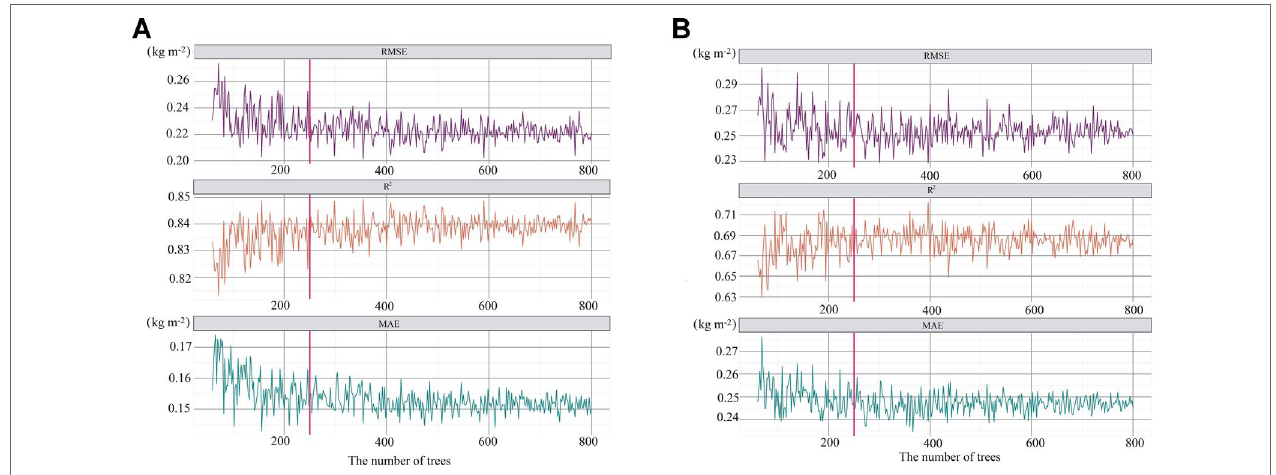
FIGURE 6 | Average accuracy of five-fold cross-validation of RF Model in training samples (A) and testing samples (B) .